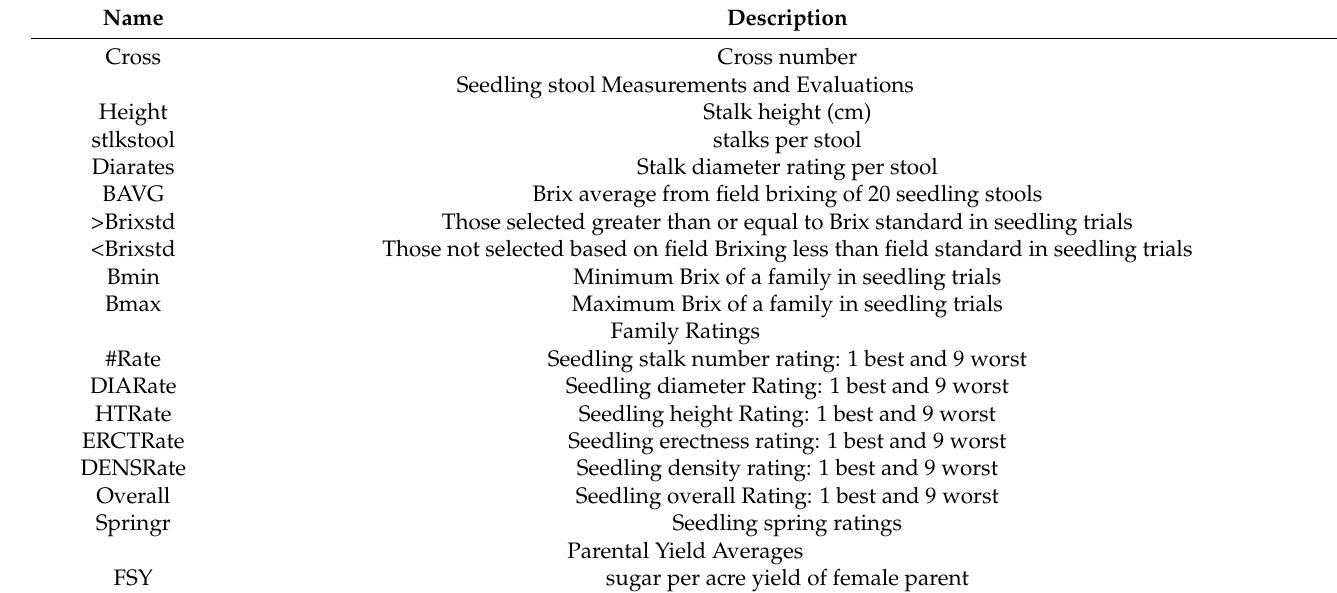
Table 2. List of traits and